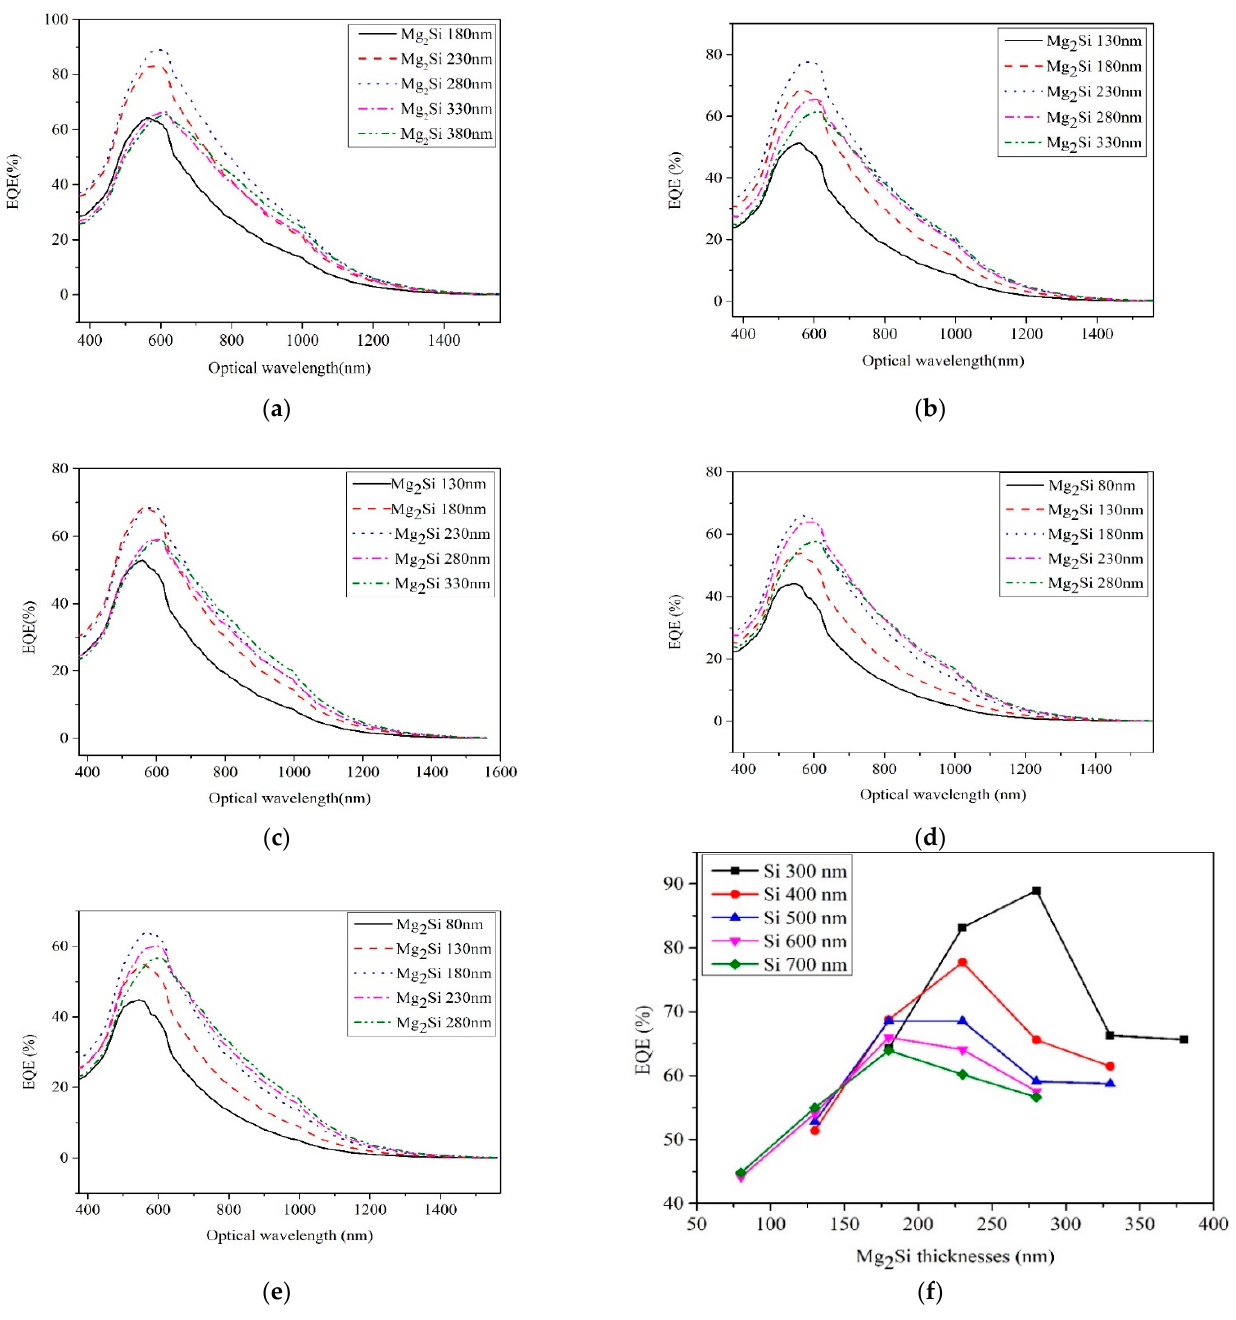
Figure 7. The EQE curves of heterojunction PD with different thicknesses of Mg 2 Si under the conditions of Si thicknesses of 300 nm, 400 nm, 500 nm, 600 nm, and 700 nm. ( a ) Si-300 nm; ( b ) Si-400 nm; ( c ) Si-500 nm; ( d ) Si-600 nm; ( e ) Si-700 nm; ( f ) The effect of thicknesses on the EQE.